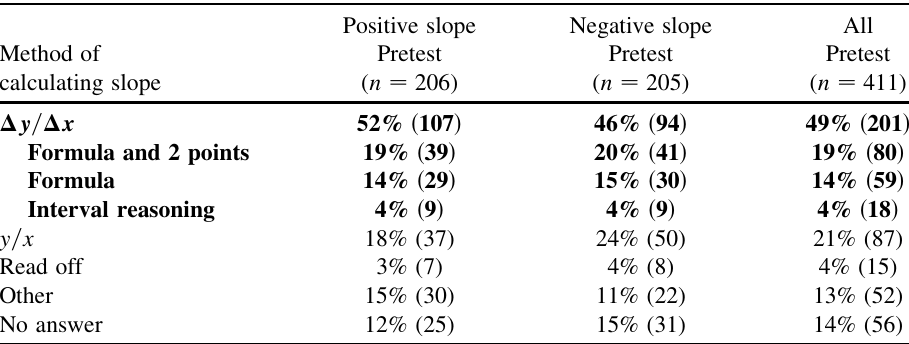
TABLE III. Pretest results for the task to determine the slope at a point on a straight line y; x graph not through the origin. The row labeled y=x includes answers in which students stated they calculated (cid:1) y= (cid:1) x , but used (0,0) as one of the points or (1,0) and (0,3) as the two points. The row labeled ‘‘interval reasoning’’ excludes students who used (cid:1) y= (cid:1) x